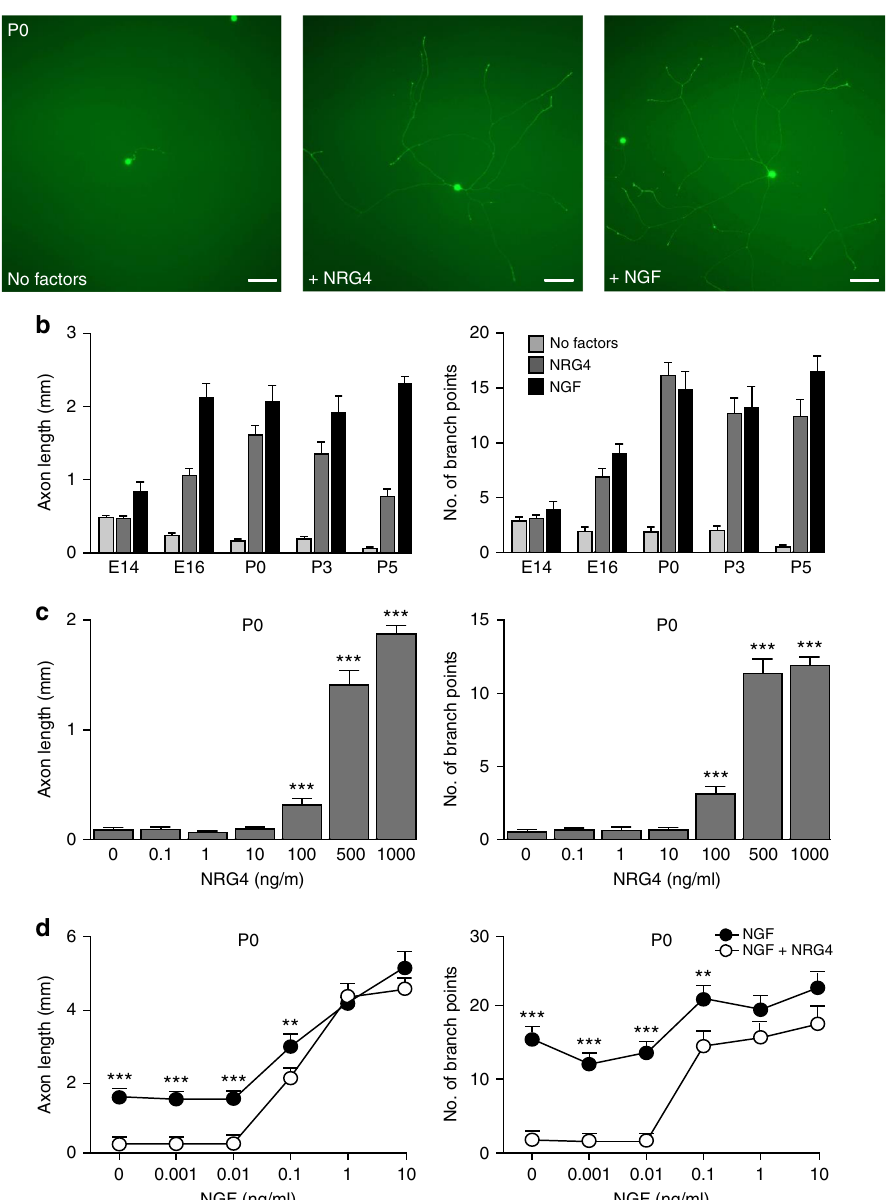
Fig. 4 NRG4 promoted primary sympathetic neuron axonal growth and branching. a Representative images of P0 primary sympathetic neurons cultured for 24 h without factors (control) or with NRG4 or NGF, Scale bar, 50 µ m. b Quanti fi cation of axon length and number of branch points in SCG neuron arbors at stage E14 to P5 cultured without factors or with either NRG4 or NGF. c Axon growth and branching dose responses of P0 SCG neurons to NRG4. d Axon growth and branching dose responses of P0 SCG neurons to NGF with and without 1 μ g/ml NRG4. Mean± s.e.m of data of >150 neurons per condition combined from 3 experiments. Mean ± s.e.m. are presented. * P < 0.05, ** p < 0.01, *** p < 0.001 compared to 0 ng/ml NRG4 ( c ) and NGF conditions ( d ) using one-way ( c ) or two-way ( d ) ANOVA with Bonferroni – Holm post-hoc multiple comparison